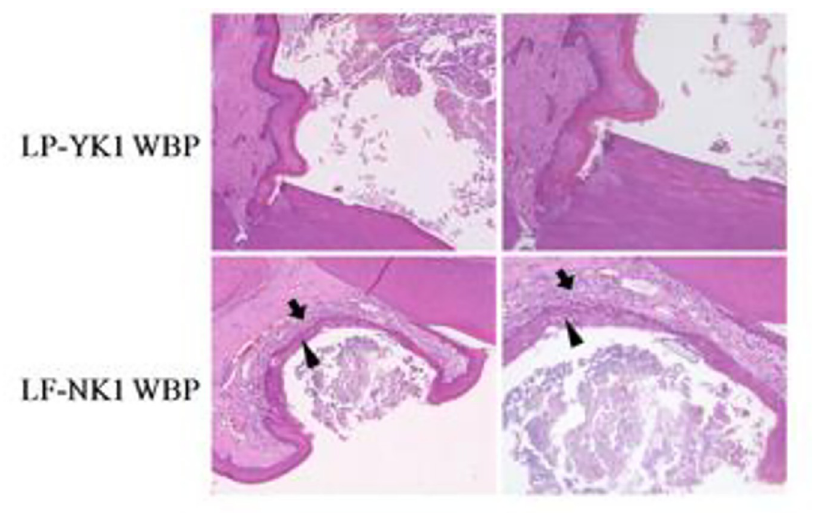
Fig 5. Histopathologic analysis of mandibular first molar tooth regions from rats administered with whey bioconversion products (WBPs) and their effects on periodontitis. LP-YK1 WBP: Administration of WBPs produced by L . plantarum SMFM2017-YK1 after inducing periodontitis, LF-NK1 WBP: Administration of WBPs by L . fermentum SMFM2017-NK1 after inducing periodontitis. Arrow: inflammatory cell infiltration, Head of arrow: epidermal hyperplasia. https://doi.org/10.1371/journal.pone.0263851.g005 PLOS ONE | https://doi.org/10.1371/journal.pone.0263851 October 6,